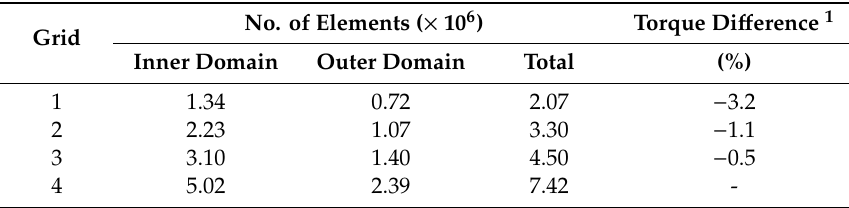
Table 2. Mesh details for sensitivity